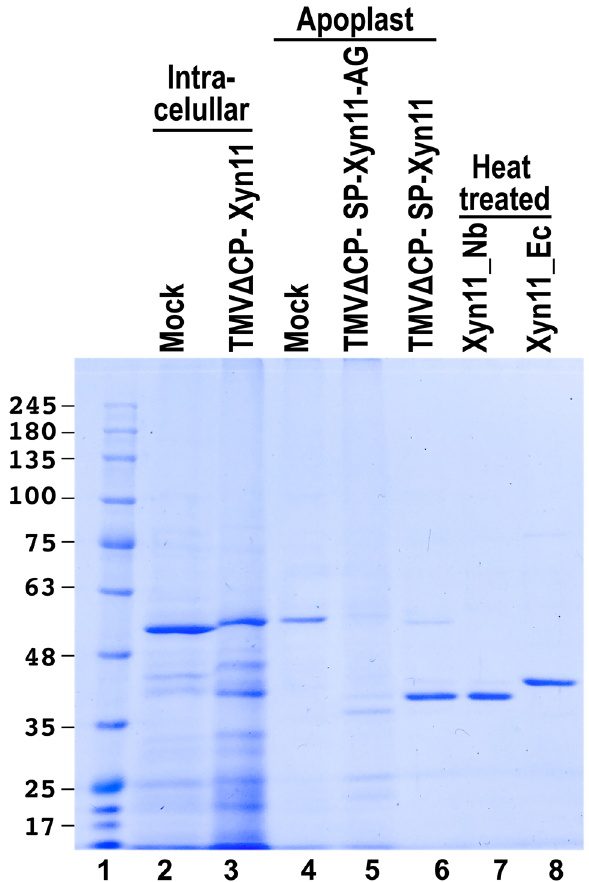
Figure 3. Comparative analysis of recombinant xylanases produced in N. benthamiana and E. coli . Lane 1, protein markers with size in kDa on the left; lanes 2 and 3, intracellular proteins from N. benthamiana mock- inoculated (lane 2) and inoculated with TMVΔCP-Xyn11 (lane 3); lanes 4 to 6, apoplastic proteins from N. benthamiana mock inoculated (lane 4) and inoculated with TMVΔCP-SP-Xyn11-AG (lane 5) and TMVΔCP- SP-Xyn11 (lane 6). Lanes 7 and 8, heat-treated preparations of xylanase Xyn11 purified from N. benthamiana apoplast (Xyn11_Nb) and E. coli